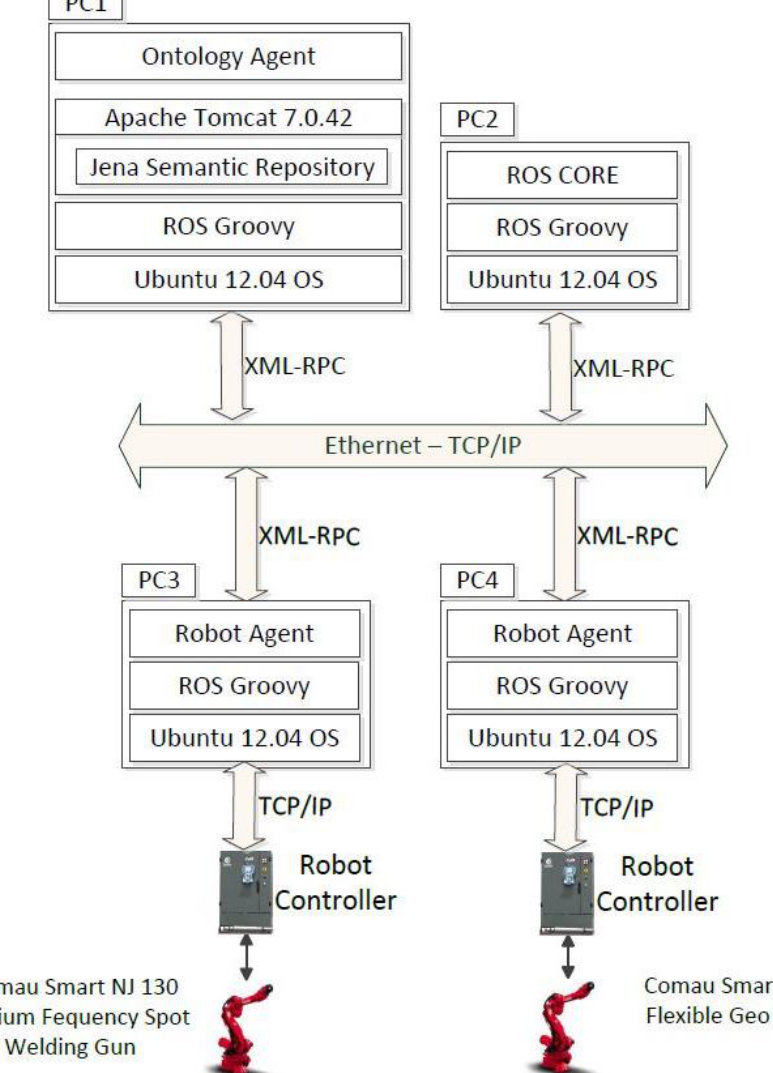
Figure 8. Hardware and software architecture of the laboratory implementation.